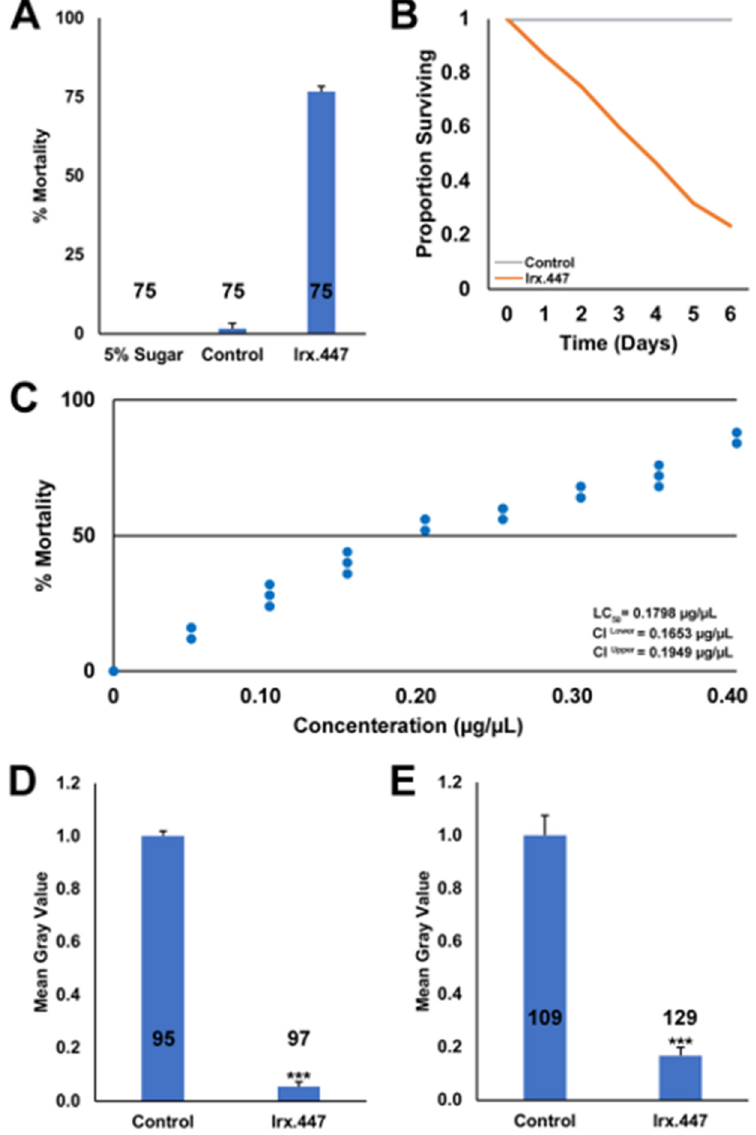
Figure 2. High A. aegypti mortality rates result from consumption of yeast RNAi-based ATSBs targeting Irx . ( A ). Significant mortality is observed following consumption of heat-inactivated Irx.447 yeast delivered to A. aegypti adult females as an ATSB. ( B ). Survival curves for adult females that consumed Irx.447 or control yeast sugar bait (in panel A ) are displayed. ( C ). A dose—response curve illustrates the concentration of Irx.447 yeast provided in the ATSB vs. the percentage mortality of A. aegypti adult females; each point corresponds to an ATSB trial conducted on 25 adult females. LD 50 values are indicated. Irx.447 ATSB consumption by A. aegypti adult females resulted in significantly reduced levels of Irx ( D ) and pdm2 ( E ) transcripts in the brain, as evidenced by mean gray value analyses. Throughout this figure: n numbers are displayed under each bar in the graphs, and error bars denote SEMs; *** p < 0.001 (Student’s t -test). 3.3. Irx.447 Yeast Selectively Kills Aedes, Culex, and Anopheles Mosquitoes An identically conserved Irx.447 target site is found in the sequenced genomes of many species of mosquitoes, including multiple Anopheles mosquitoes, A. albopictus , and C. quinquefasciatus (Table S1). It was hypothesized, on the basis of the outcomes of the ATSB and larvicide trials in A. aegypti (Figures 1 and 2), that Irx.447 yeast may act as a broad-range mosquito IRP that can kill at multiple life stages in different species of mos-